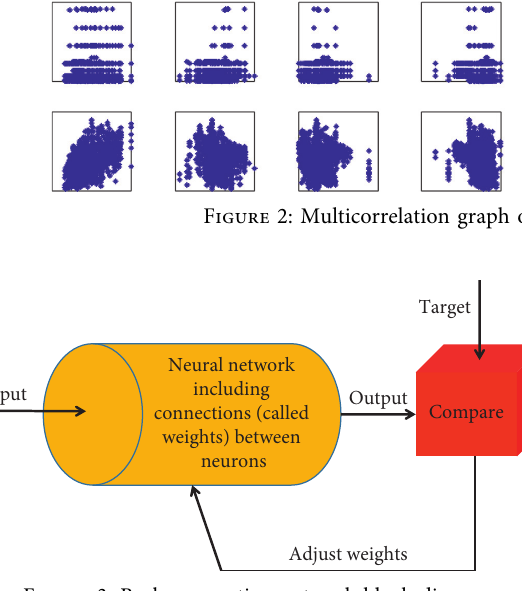
Figure 3: Backpropagation network block